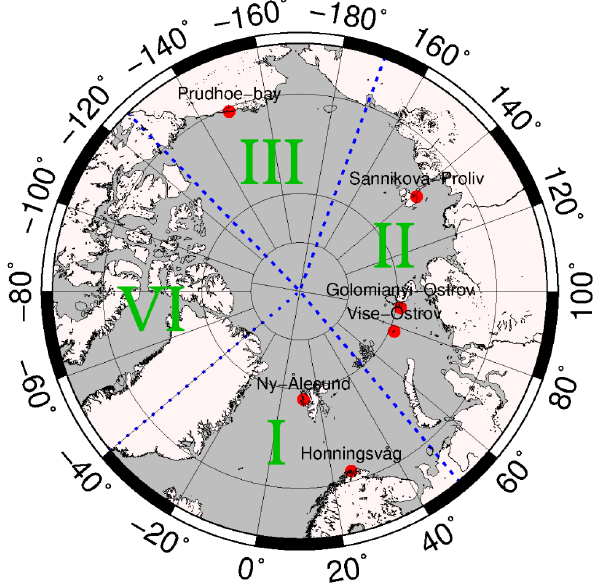
Figure 1. Overview map of the Arctic Ocean. The map show the tide gauges (red dots) used to validate the SLA and the different sectors (divided in blue punctured lines) used to investigate the different Arctic regions. The four regions are: I: Fram Strait, Greenland Sea, Norwegian Sea and Barents Sea. II: The Russian Arctic: Kara Sea and Laptev Sea, III: East Siberian Sea and Beaufort Sea, IV: The Canadian Archipelagos and Baffin